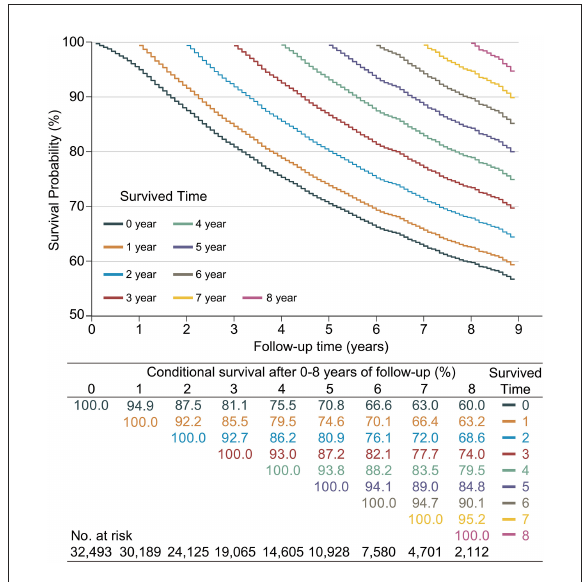
FIGURE2 Kaplan–Meier method for estimating conditional survival (CS) of locally advanced breast cancer (LABC) at given years of survival. Each curve represented to the survival rate after a given number of years (e.g., the orange curve indicated the survival after given 1 year of follow-up [CS(y|1)]), which corresponded to the orange row in the table, i.e., after given 1 year of follow-up, survival in the 2nd year was 92.2% [CS(1|1)] and 66.4% [CS(6|1)] in the 6th year; Additionally, each column in the table represented the patient’s survival after given different follow-up times, e.g., the survival in year 8 was adjusted from an initial 60.0% [CS(8|0)], gradually adjusted to 95.2%